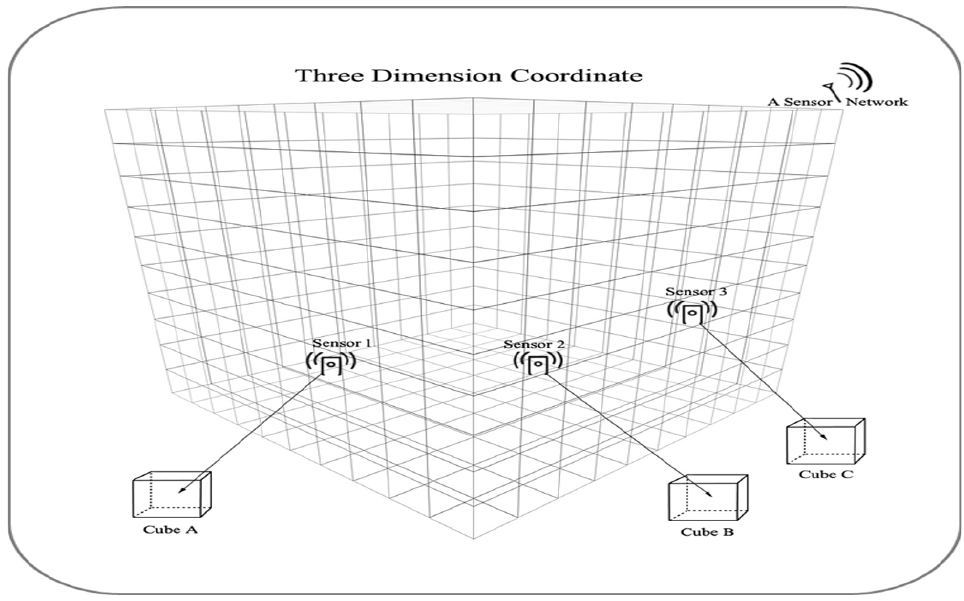
Figure 1. Definition of real 3D space.